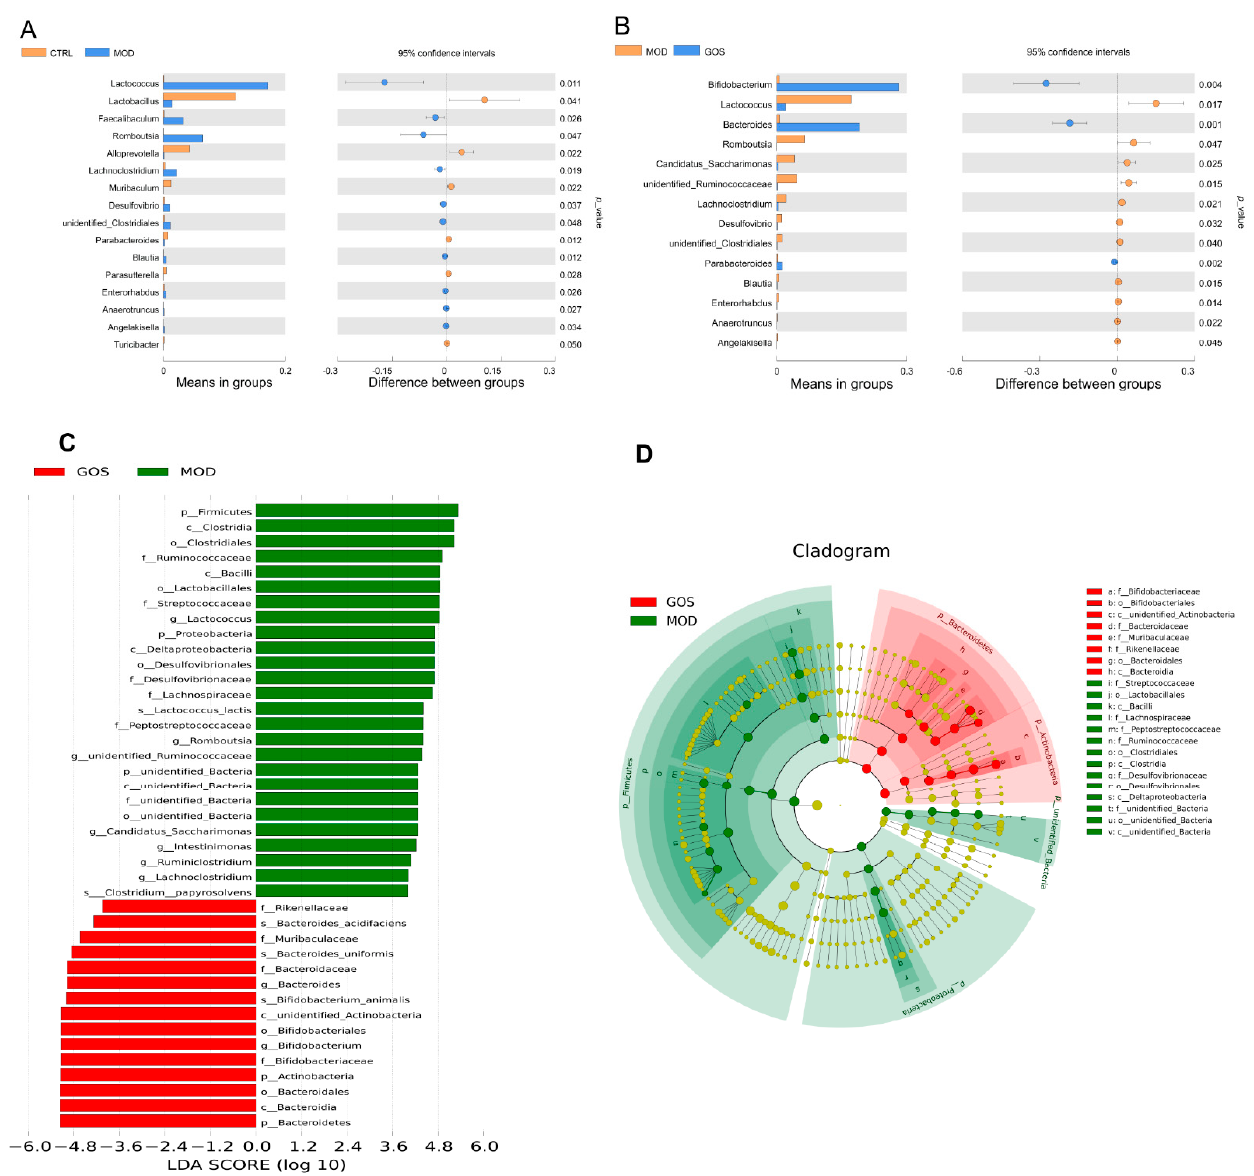
Figure 10. Species difference analysis diagram between t -test groups: ( A ) The control group vs the model group ( n = 5), ( B ) the model group vs the GOS group ( n = 5). ( C ) Histogram of LDA value distribution ( n = 5), ( D ) LEfSe analysis evolutionary branch diagram ( n = 5).